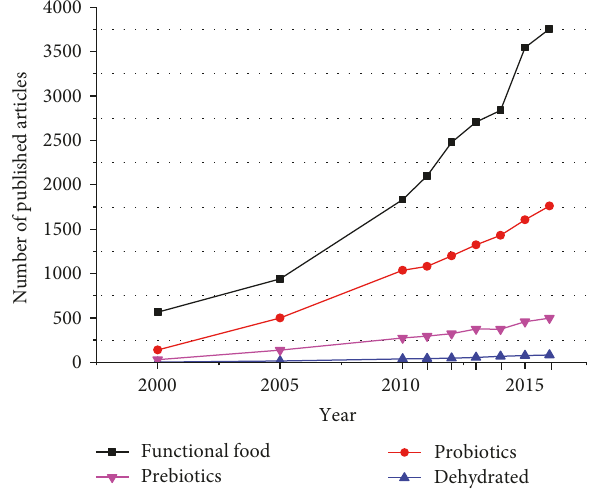
Figure 1: Number of published articles, from 2000 to 2016, related to the concepts of “Functional food,” “Probiotics,” “Prebiotics,” and “Dehydrated functional food” (Web of Science, 2017)